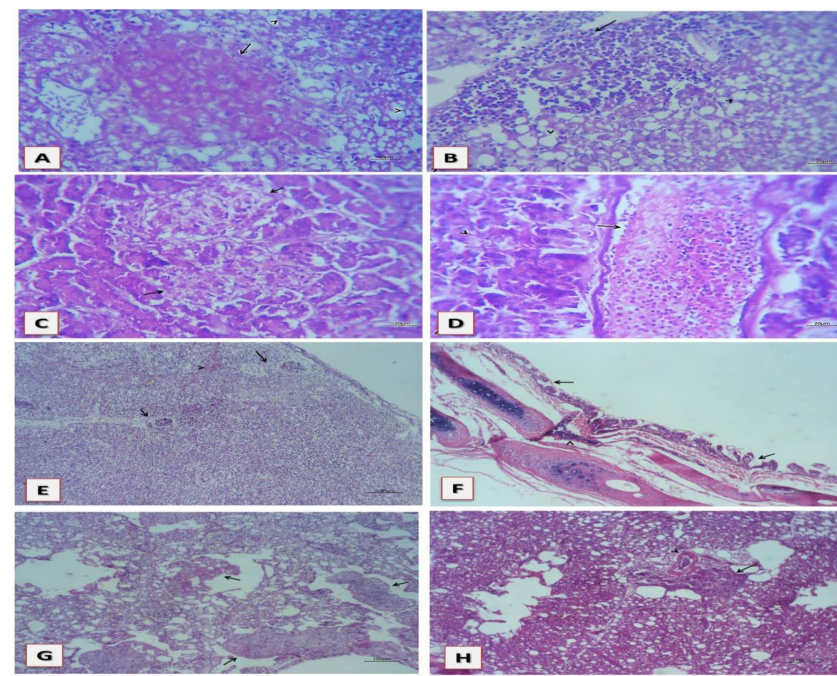
Figure 3. Histopathological changes of H5 AIV in infected chickens: ( A ) liver showing focal necrotic area encircled by a few heterophils and lymphocytes (arrow); ( B ) liver showing portal lymphocytic and heterophilic aggregation (arrow) with necrotic and degenerated hepatic cells (arrow head); ( C ) pancreas showing multiple necrotic areas (arrow); ( D ) pancreas showing minute thrombus admixed with intense heterophils (arrow) besides degenerated and necrotic acini (arrow head); ( E ) spleen showing severe lymphoid depletion of white pulps and minute necrotic areas (arrow head); ( F ) trachea showing hyperplastic mucus glands and mucosal epithelium (arrow) and leukocytosis of sub mucosal B.V.S. (arrow head); ( G ) lung showing disseminated mucus casts containing erythrocytes inside bronchi (arrow); ( H ) lung showing intense perivascular leukocytic aggregation (arrow) and hyalinized vascular wall with endotheliosis (arrow